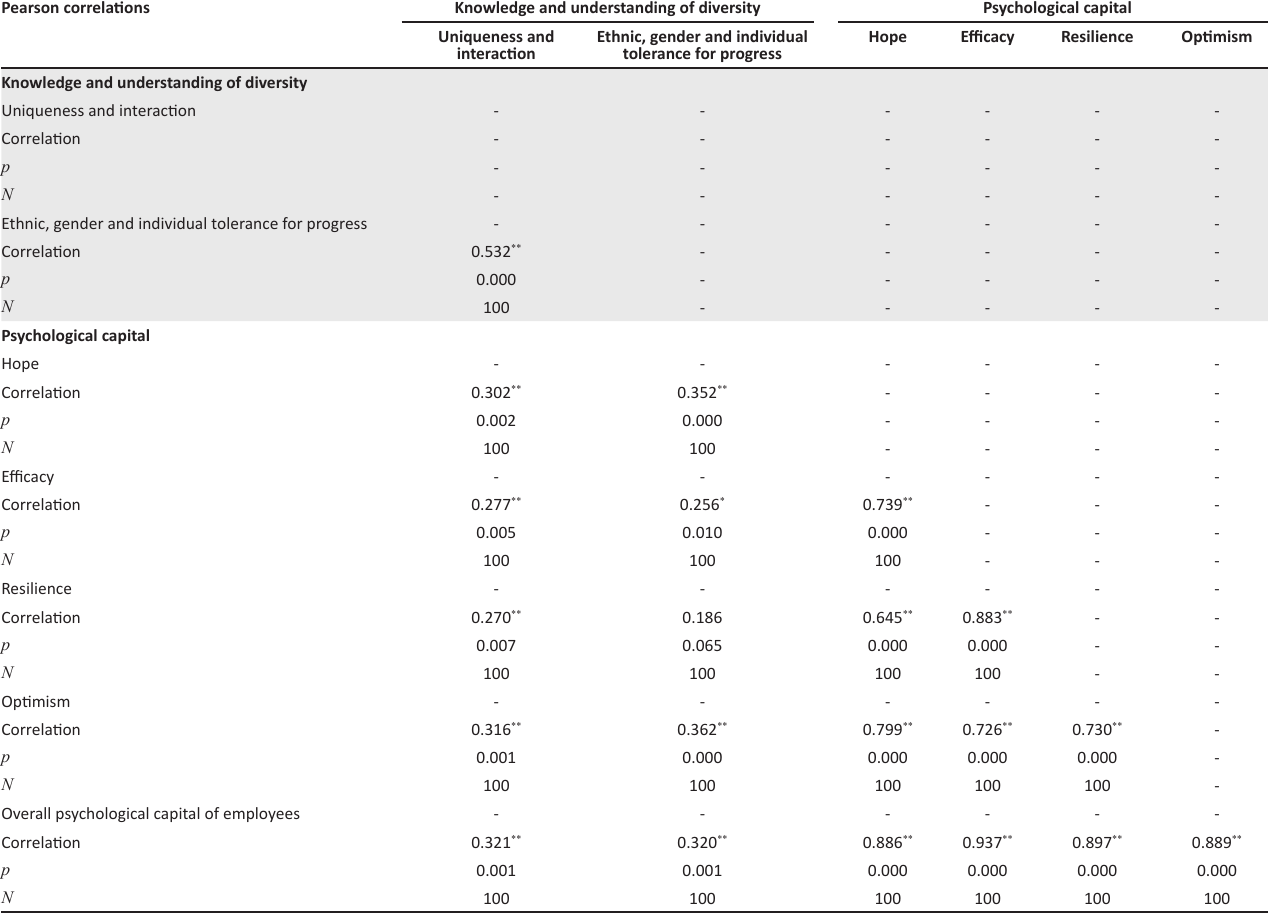
TABLE 17: Correlations of knowledge and understanding of diversity and psychological capital variables. Pearson